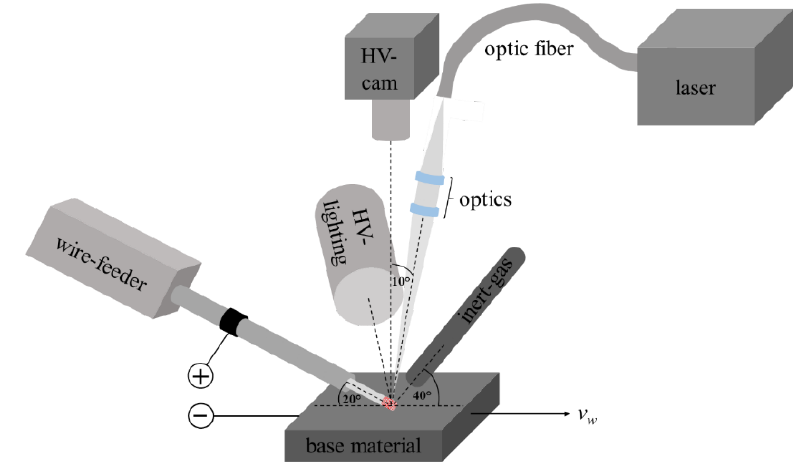
Figure 2. Schematic representation of the experimental setup.